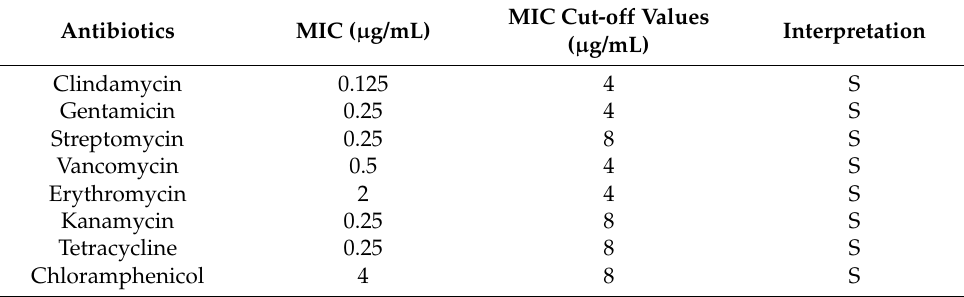
Table 4. W. coagulans PL-W sensitivity to